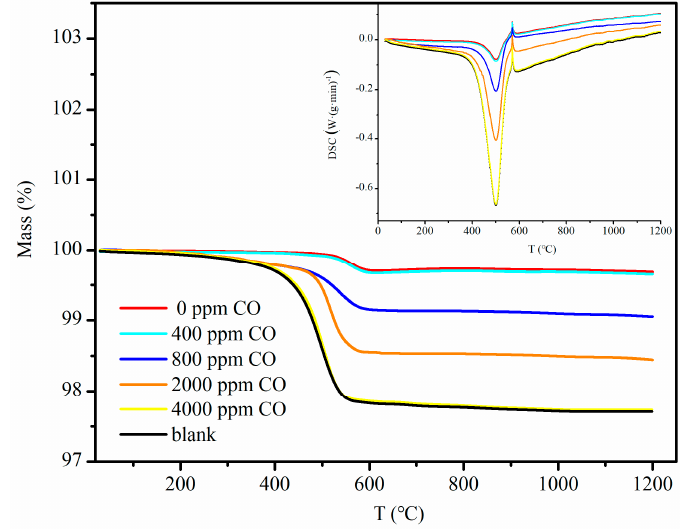
Figure 3. TG–DSC curves for the char residues. Table 3. Mass loss of rice husk char residues.